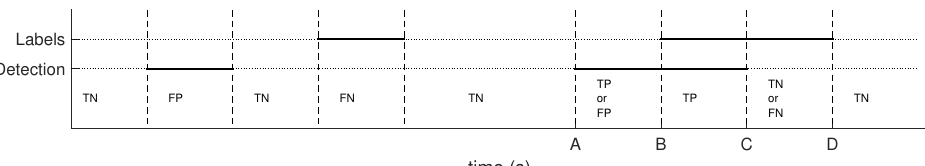
Figure 4. Detection evaluation. Horizontal bold lines represent detected segments. The horizontal dotted line stands for segments labeled as artifact-free data. Vertical dashed lines are the ends of all labeled